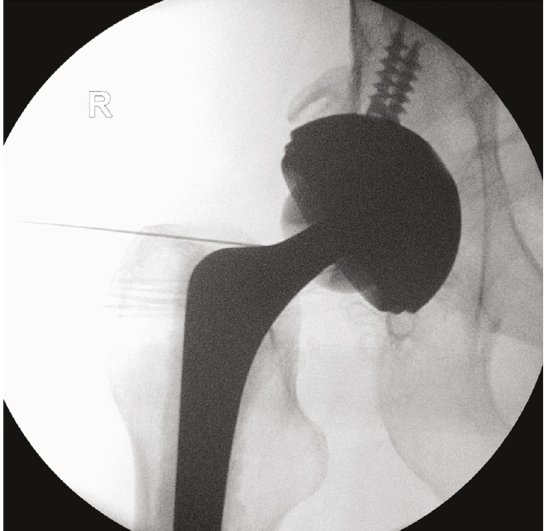
Figure 2: Image intensi fi er picture showing aspiration of the total hip